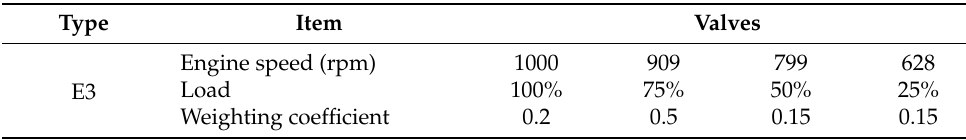
Table 4. The Weighting Coefficient of E3 Test Cycle.